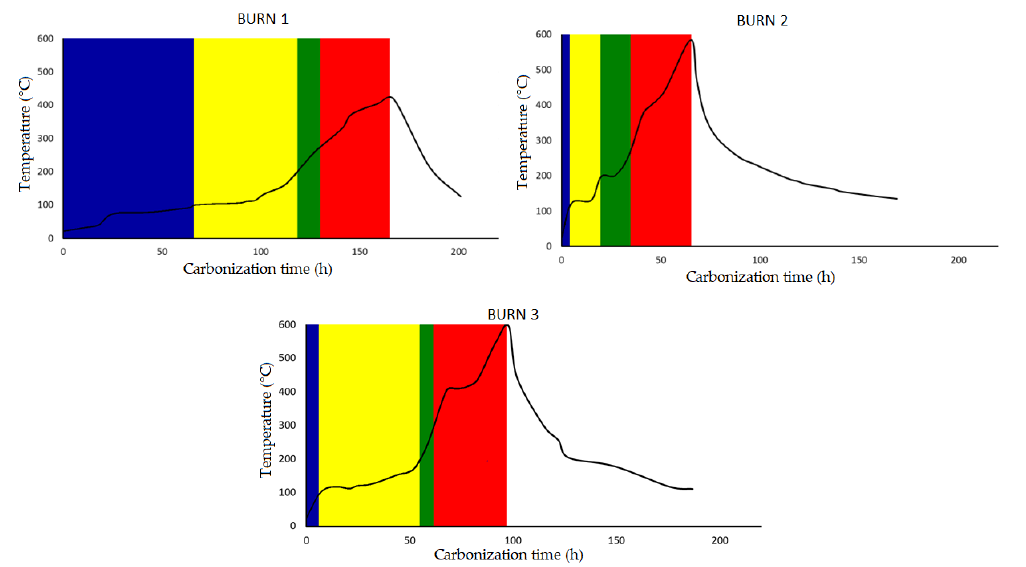
Figure 7. Heating ramps during carbonization in three burnings of modified Brazilian beehive kilns. Blue color = phase 1, yellow color = phase 2, green color = phase 3, red color = phase 4, white color = phase 5. This carbonization process includes the following species: Guamúchil and Tamarindo. Table 4. Burning time and heating ramps on each phase during carbonization in modified Brazilian beehive kiln.